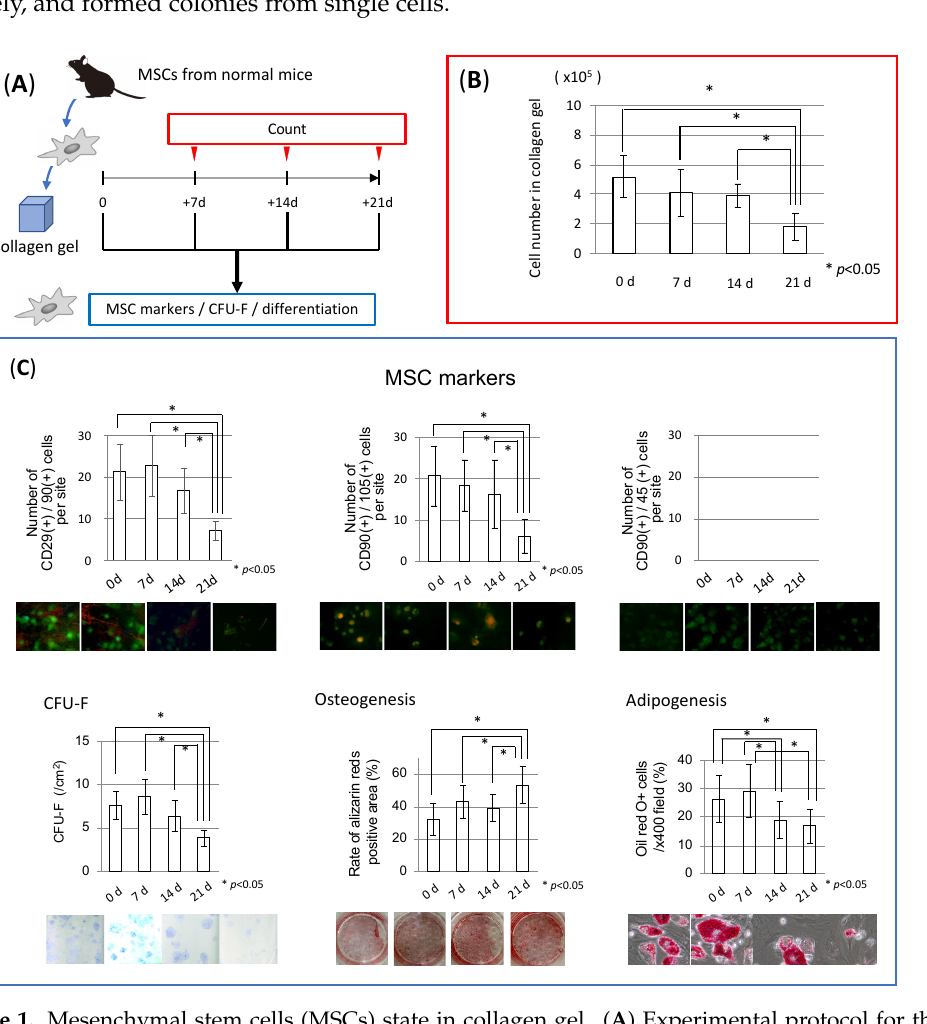
Figure 1. Mesenchymal stem cells (MSCs) state in collagen gel. ( A ) Experimental protocol for the in vitro study. MSCs isolated from wild-type C57BL / 6N mice were cultured in a collagen gel for 3